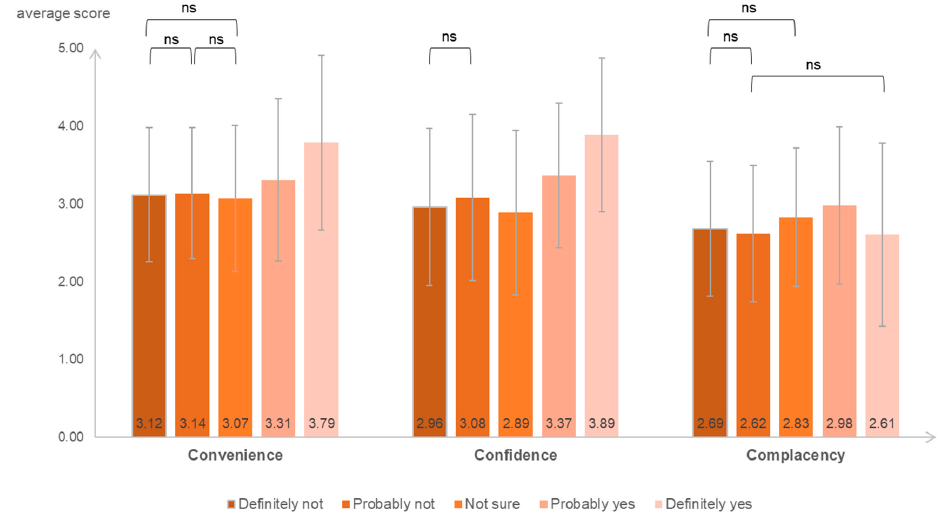
Figure 2. Average scores based on the “3Cs’ model” were categorized by the question about influenza vaccine willingness and the results of multiple comparisons. The WHO used the “3Cs’ model” to classify vaccine hesitancy: confidence, complacency, and convenience, shown at the x -axis. The y -axis represented the average five-point Likert scale of these three central factors. The differences between answers were significant at 0.01 statistical level unless noted “ns” by a connecting line. ns: not significant.